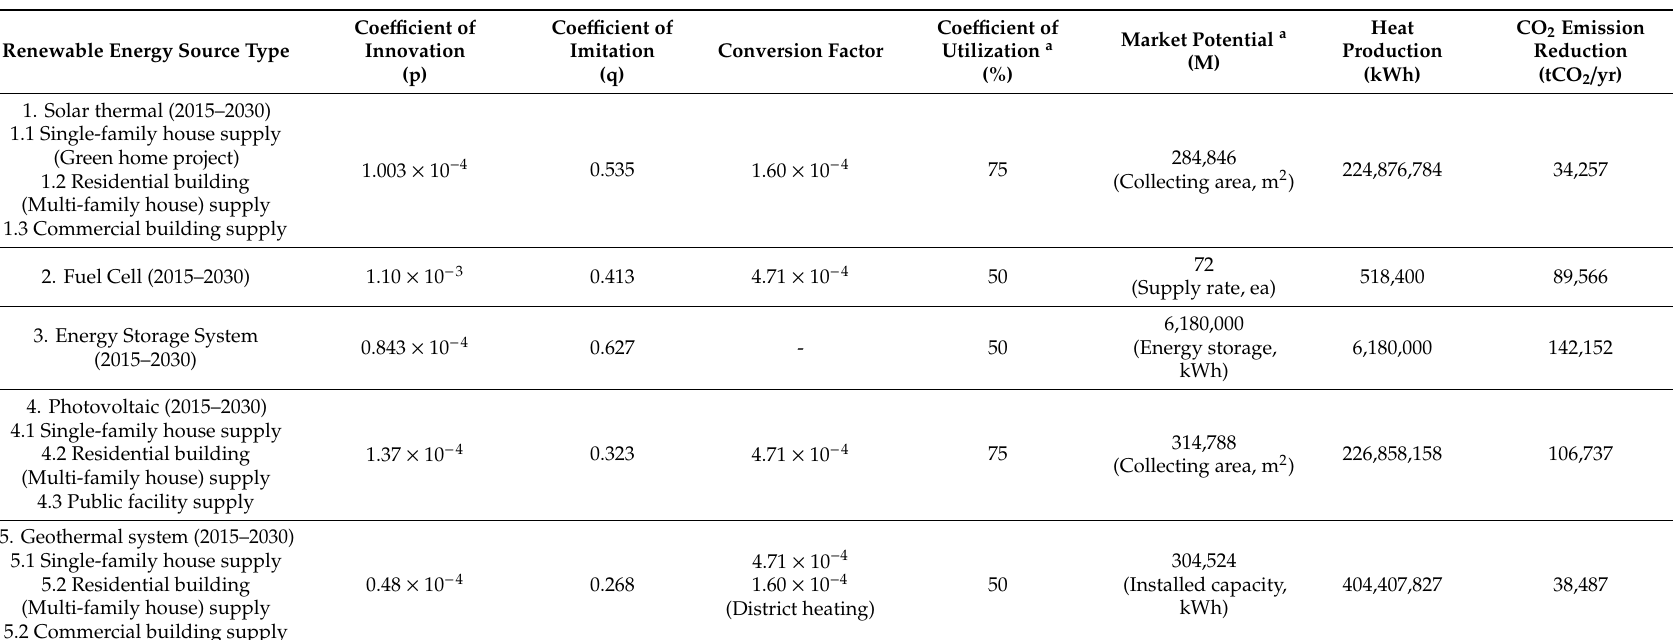
Table 4. Results from the Renewable Energy Supply Target (REST) Scenario: Used in the Bass Di ff usion Model. Renewable Energy Source